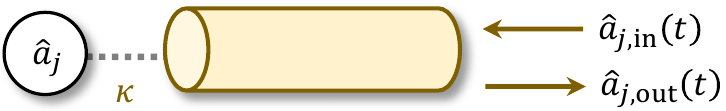
) coupled to an j encodes the amplitude of signals j ,in encodes the amplitude of signals and j ,out